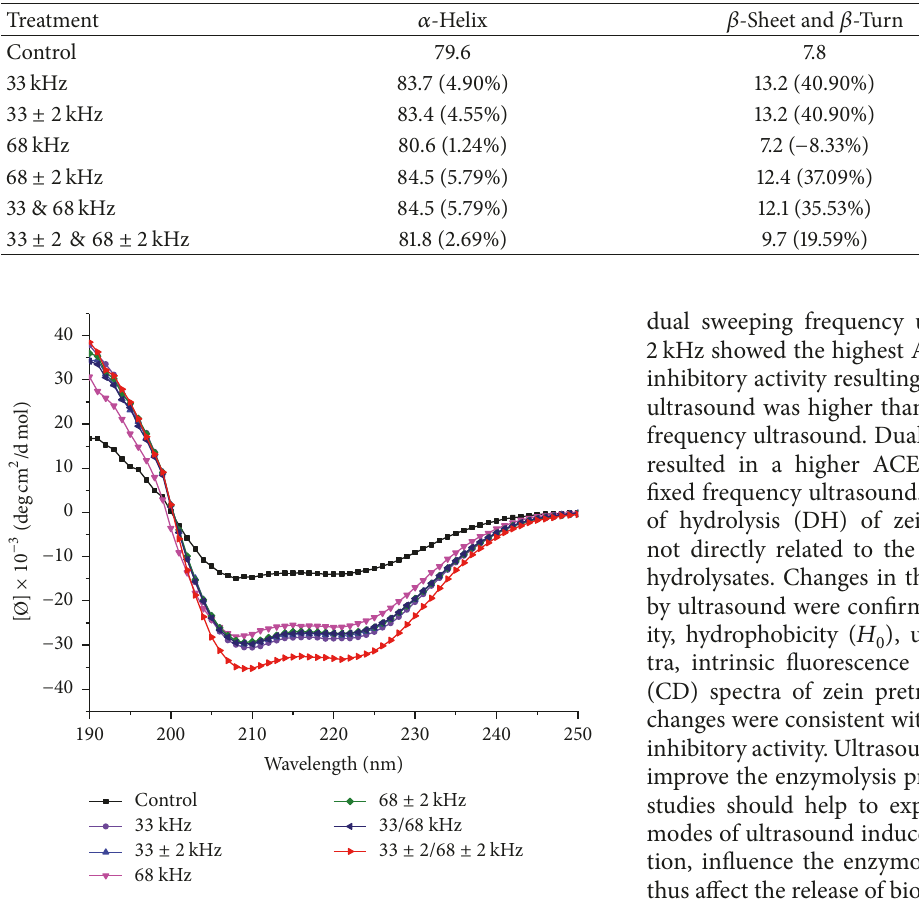
Table 1: Effects of pretreatment with ultrasound bath with four different working modes and two frequencies on the secondary structure content (%) of zein.